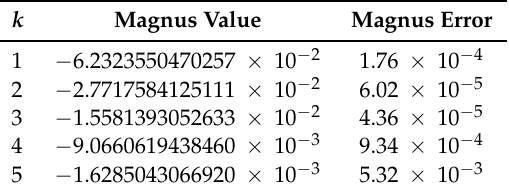
Table 3. Eigenvalues and absolute errors for the first five eigenvalues of Equation (29) using Magnus method.